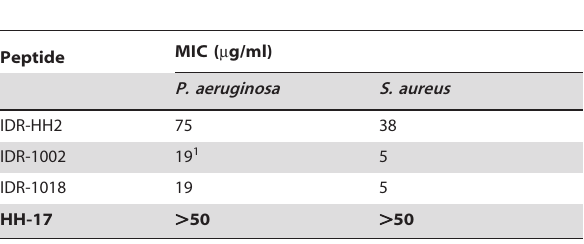
Table 2. Direct antimicrobial activity of the IDR peptides vs. Gram negative pathogen Pseudomonas aeruginosa and Gram positive pathogen.